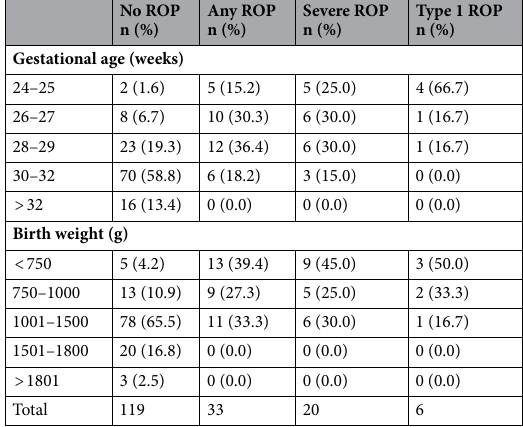
Table 1. Rate of ROP stratified by gestational age and birth weight.